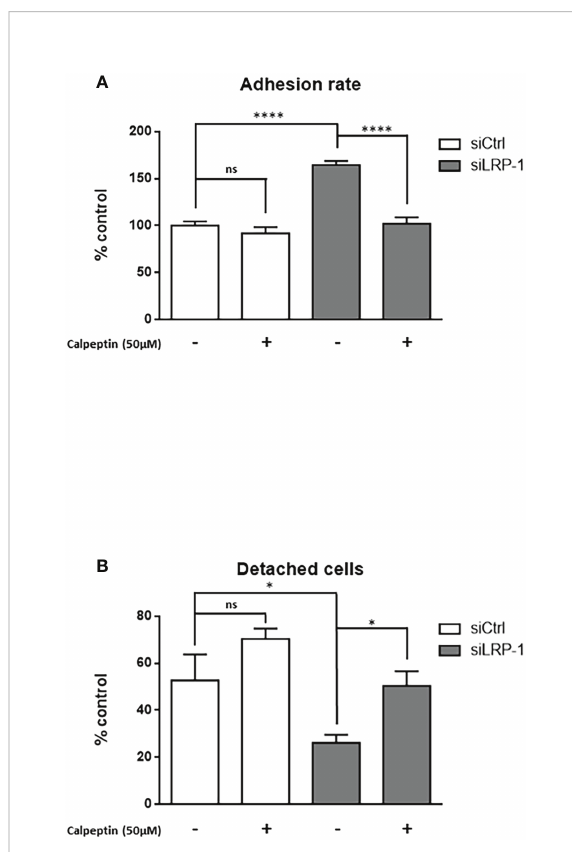
FIGURE 3 Calpain activity modulates carcinoma cells adhesion strength. FTC133 cells transfected with siCtrl or siLRP-1 RNA were seeded onto gelatin-coated plates in presence or absence of 50µM calpeptin, and the non-adherent cells were discarded after 60 minutes (A) . Transfected tumor cells were grown in gelatin- coated dishes for 24 hours and subjected to trypsinization assay by incubating cells with 0,025% (wt/vol) trypsin for 10 minutes (B) . For each cell condition, results are expressed as mean percentages of attached or detached cells ± sem, relative to control set to 1. ns, not signi fi cant; *, P < 0,05; ****, P <